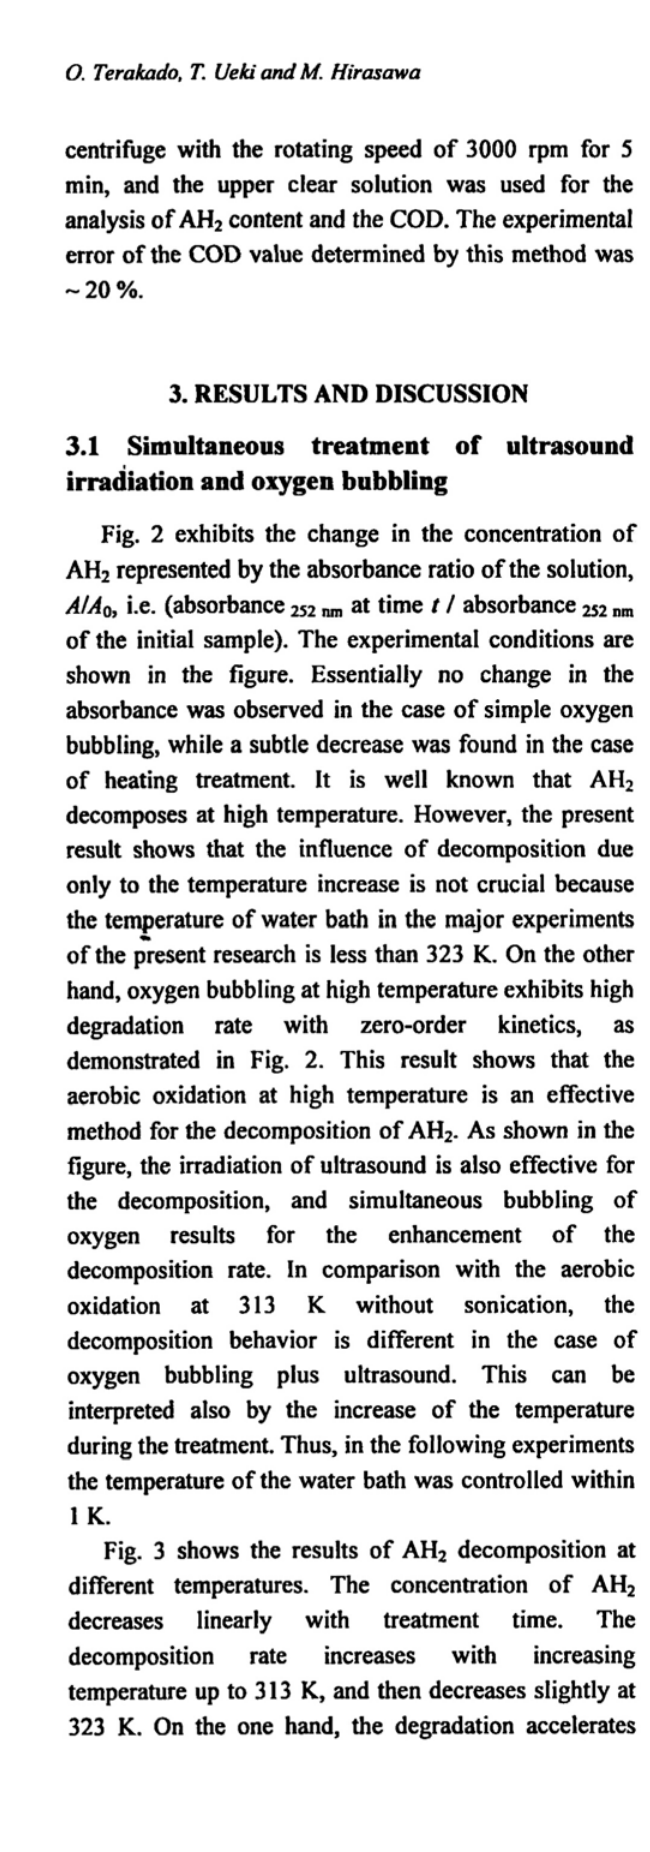
Fig. 3: Temperature dependence of decomposition behavior of AH 2